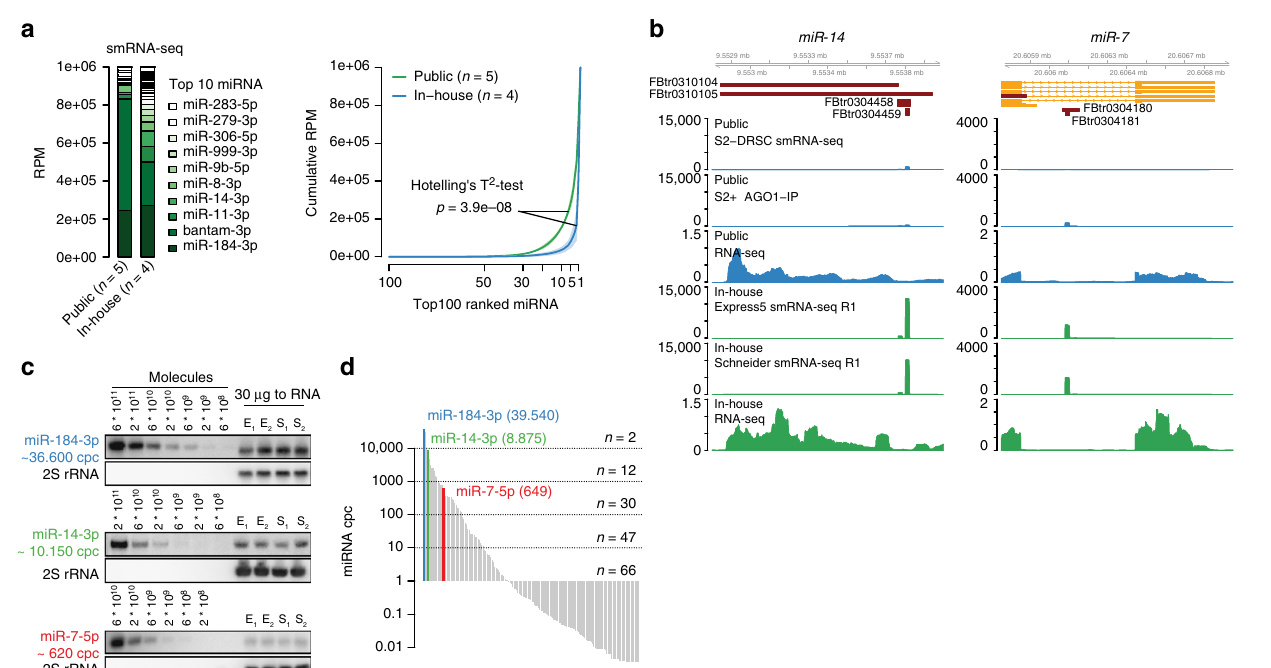
Fig. 1 miRNA expression in Drosophila S2 cells is more complex than previously reported. a miRNA quanti fi cation in publicly available and in-house smRNA- seq samples. miRNA annotated reads were normalized to reads per million (RPM). (Left) Barplot representing the mean RPM across replicates and sorted by in-house RPM. (Right) Cumulative miRNA RPM distribution of top 100 detected and RPM-ranked miRNAs. The solid line represents the mean across libraries, shades represent the standard deviation (Supplementary Data 1). b Genome browser shot showing miR-14 and miR-7 reads and their respective RNA-seq coverage at miRNA loci of representative libraries normalized to total library size. Two S2 cell sub-clones have been used for new small RNA sequencing, denoted as Express5 and Schneider, respectively. c Quantitative miRNA northern blot for miR-184-3p, miR-14-3p, and miR-7-5p, including their experimentally determined cpc. 2S rRNA served as a loading control for total RNA samples. Source data are provided as a Source Data fi le. d Ranked distribution of fi tted cpc values (Supplementary Data 1). Y -axis is in